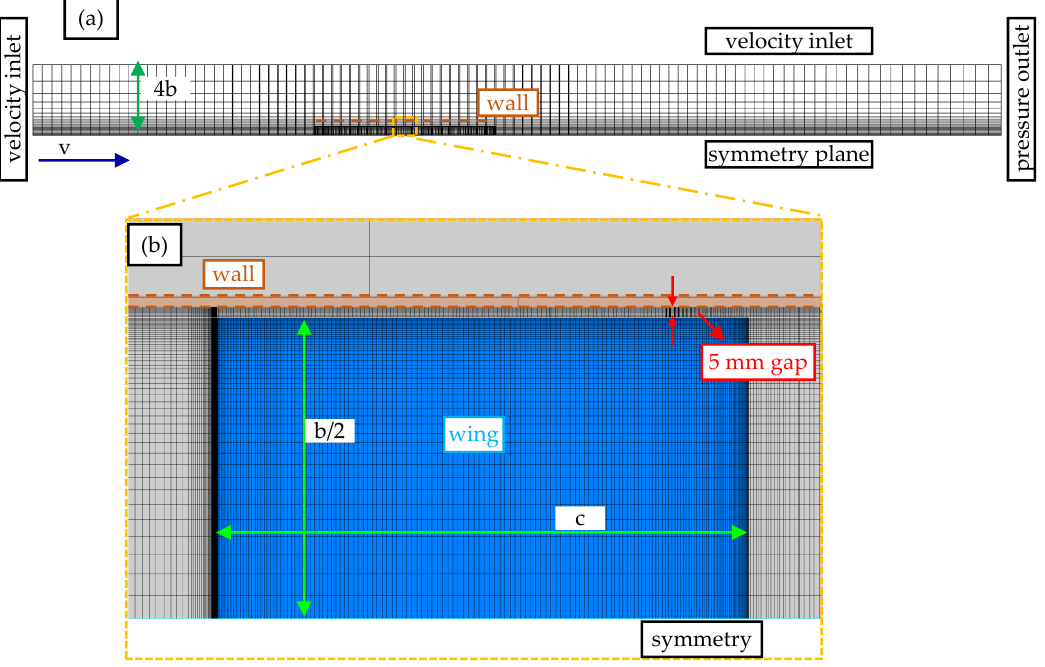
Figure 15. Top view of the computational mesh for the deformed wing. ( a ) Full view. ( b ) Cutting plane for Zoom-in mesh detail around the airfoil.